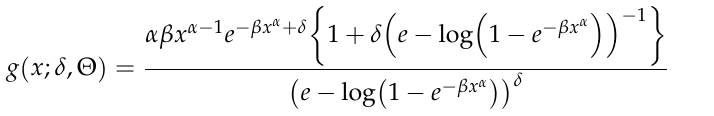
are sketched for (i) δ = 3.0, β = 3.5, α = 0.3 (in red), (ii) δ = 3.0, β = 5.0, α = 1.9 (in green), shows four different shapes of the PDF g ( x ; δ , Θ ) , including (i) decreasing or a reverse-J pattern (in red), (ii) right-skewed (in green), (iii) symmetrical (in black), and (iv) left-skewed (in